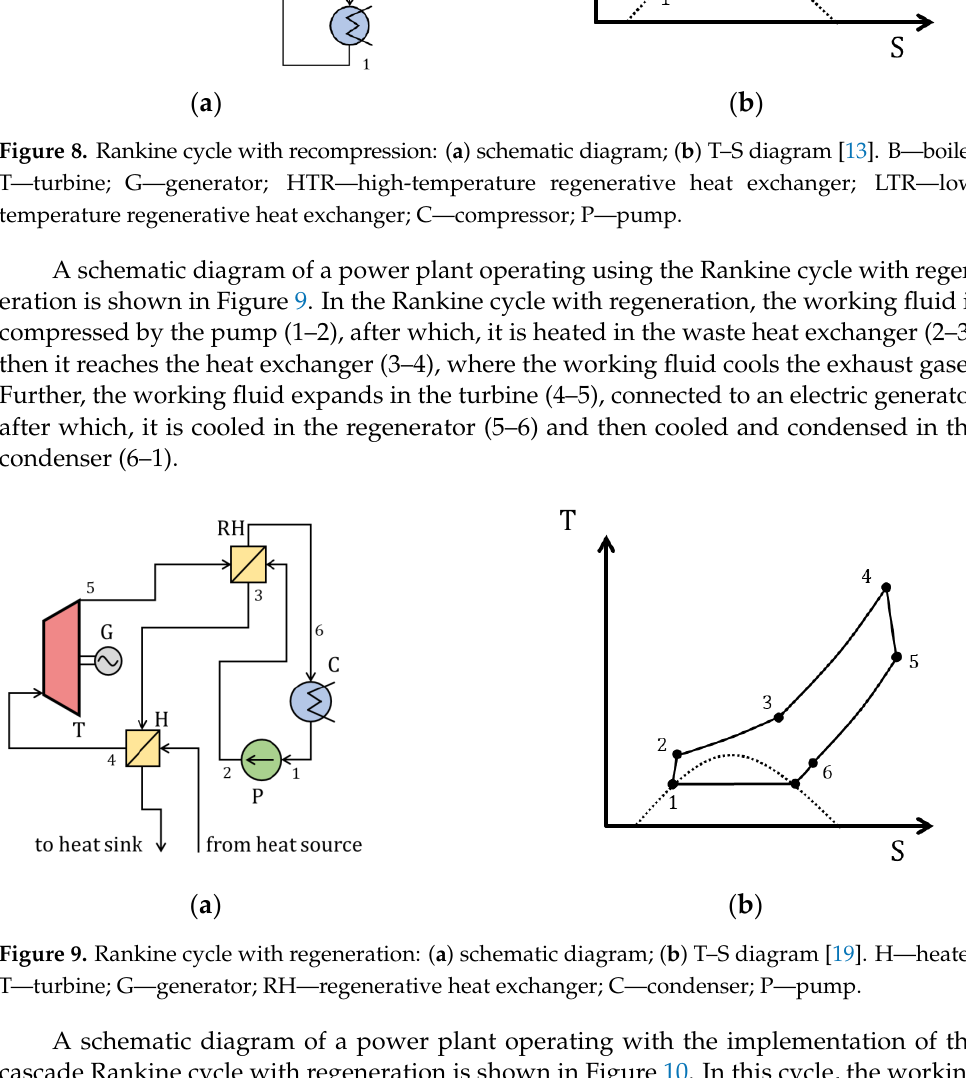
T—turbine; G—generator; HTR—high-temperature regenerative heat exchanger; LTR—low-